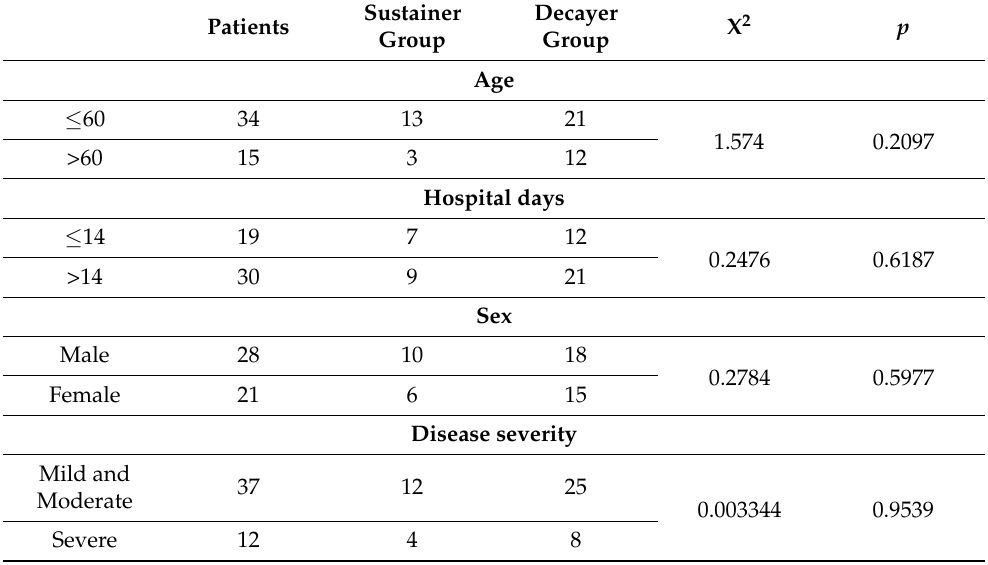
Table 2. Effect analysis of age, hospital days, sex, and disease severity on NAbs durability index in SARS-CoV-2 Recovered